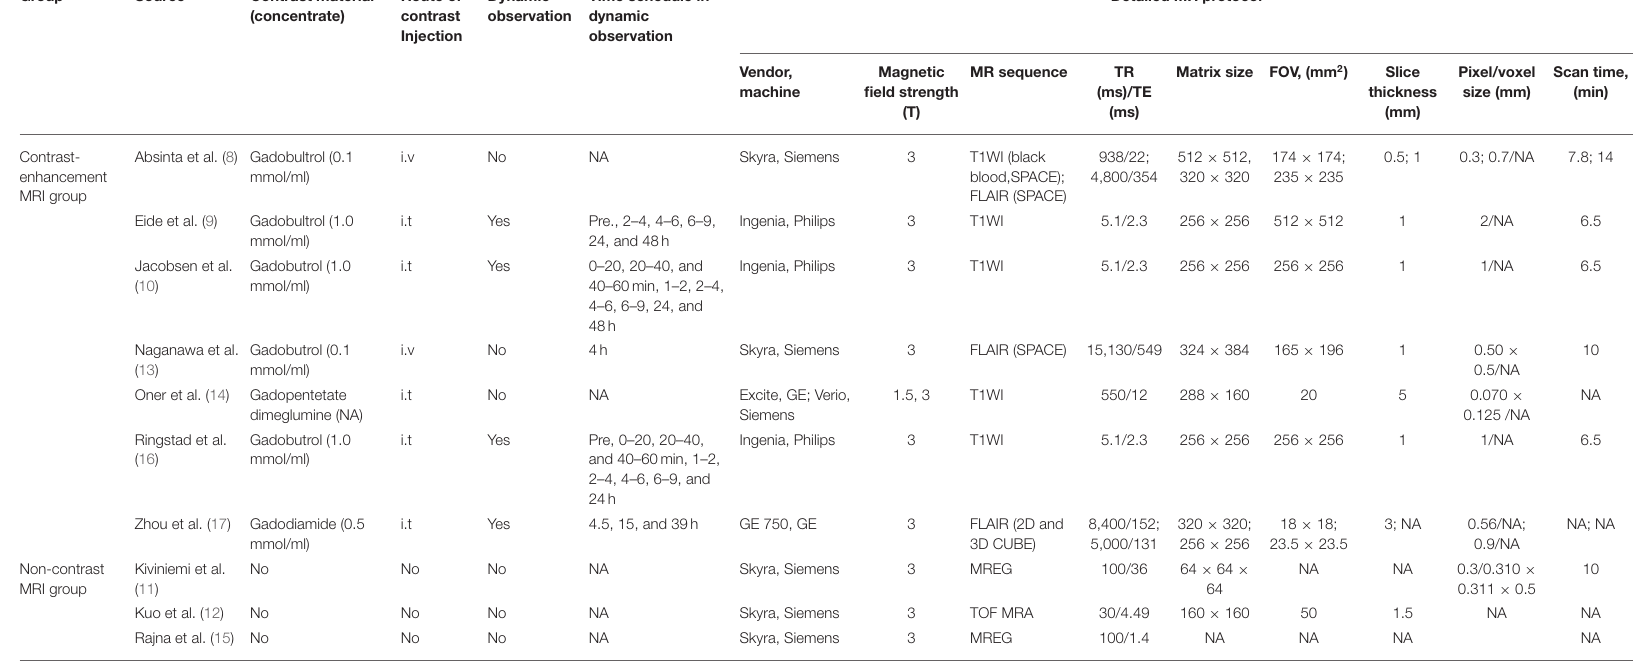
TABLE 2 | MRI sequence used for glymphatic assessment. Group